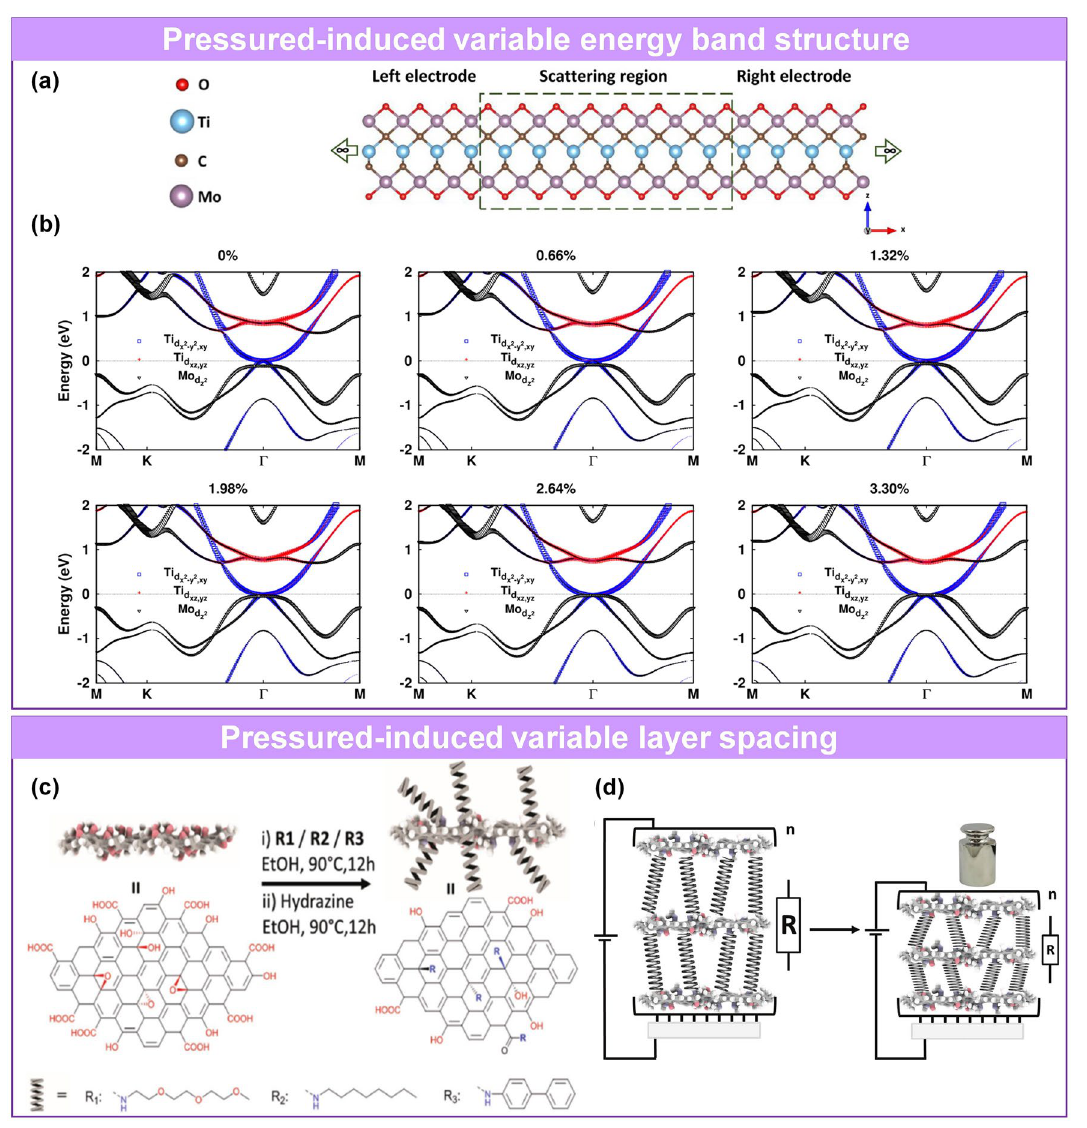
Fig. 3 Sensing materials with nanometer-scale variable structures. a Model of Mo 2 TiC 2 O 2 junction. b Electronic band structures of compressed Mo 2 TiC 2 O 2 , where the energy levels are indicated by the dashed lines [94]. Copyright (2020) Elsevier. c Schematic diagram of covalent con- nections between different rigid molecules (R 1 , R 2 , R 3 ) and graphene. d Working principle of pressure sensor and contact variation of pressure unloading/loading [96]. Copyright (2018)